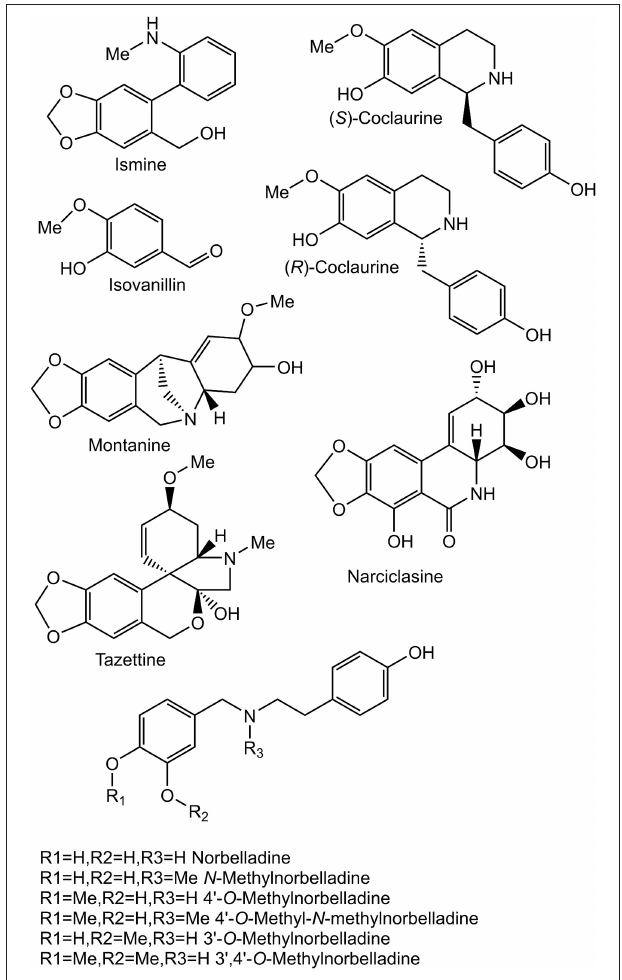
FIGURE 2 | Structures of relevant